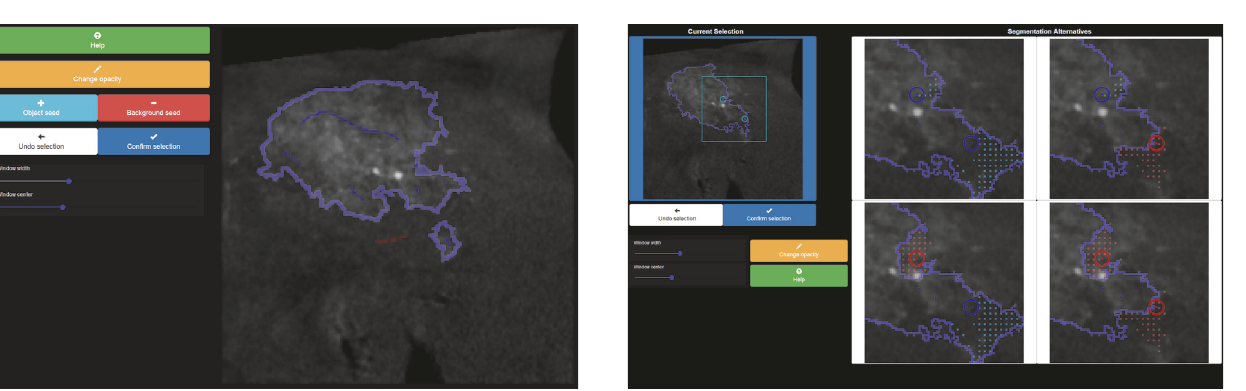
Figure 2: Semi-manual segmentation prototype user interface. The current segmentation’s contour line (light blue) is adjusted towards the user’s estimate of the ground truth segmentation by manually adding foreground (blue) or background (red) seed points.